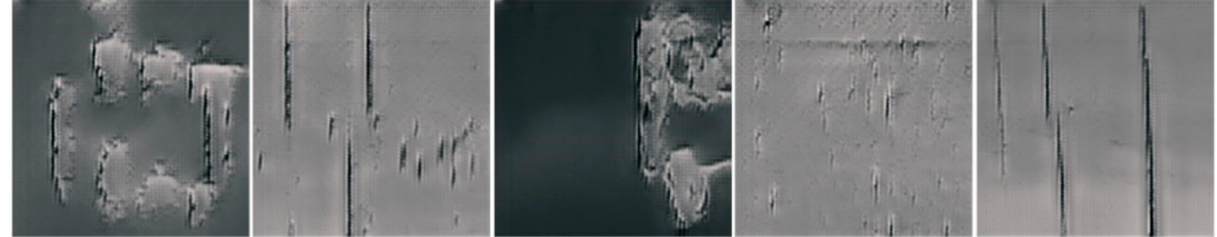
Figure 9. Sample conveyor belt damage images; damage types are cracks, tears and